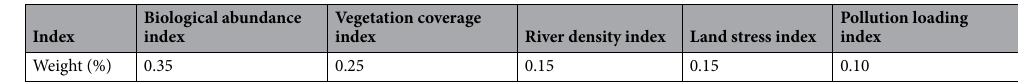
Table 1. Weights of the evaluation